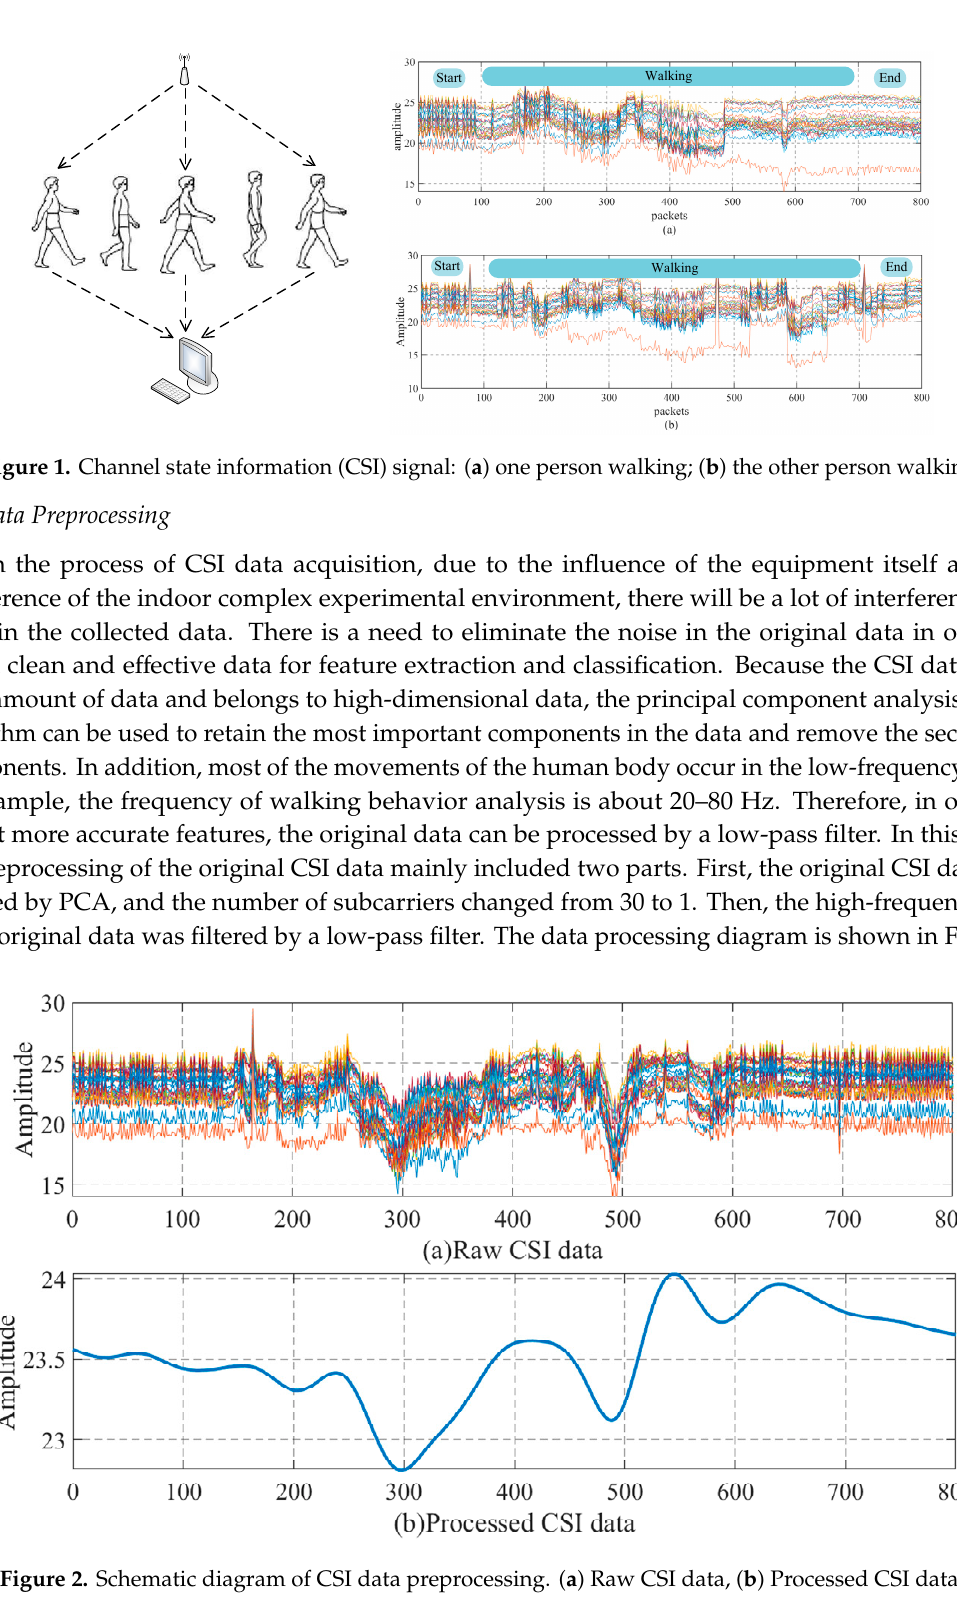
Figure 1. Channel state information (CSI) signal: ( a ) one person walking; ( b ) the other person walking.